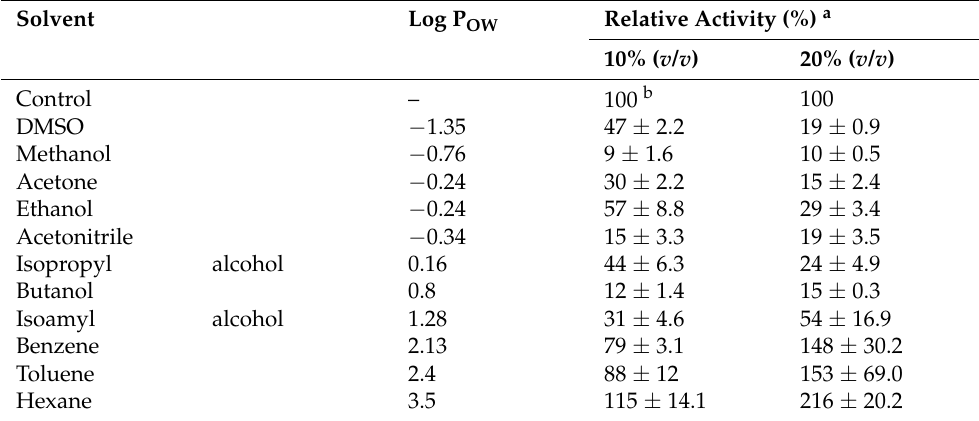
Table 4. Effect of various 10 or 20% organic solvents on MG9373